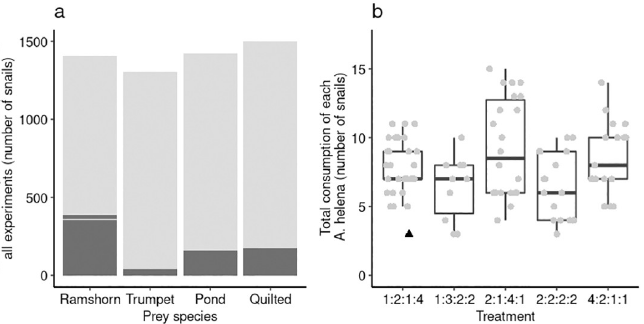
Fig 2. Total prey consumption overall and per treatment per predator. Total consumption of each prey species by A. helena (n = 97) over all treatments (a) and total consumption of prey snails at each treatment over the 14-day experimental period (b). All prey types were regularly consumed, however different numbers were consumed (dark grey: consumption; light grey: abundance). In (b) prey species are respectively, Ramshorn snails, Malaysian Trumpet snails, Pond snails, and Quilted melania snails. Box-plots with interquartile ranges and median, whiskers are up to the most extreme value within 1.5 times the interquartile range from the interquartile range. Individual points represent individual predators, outliers are indicated by